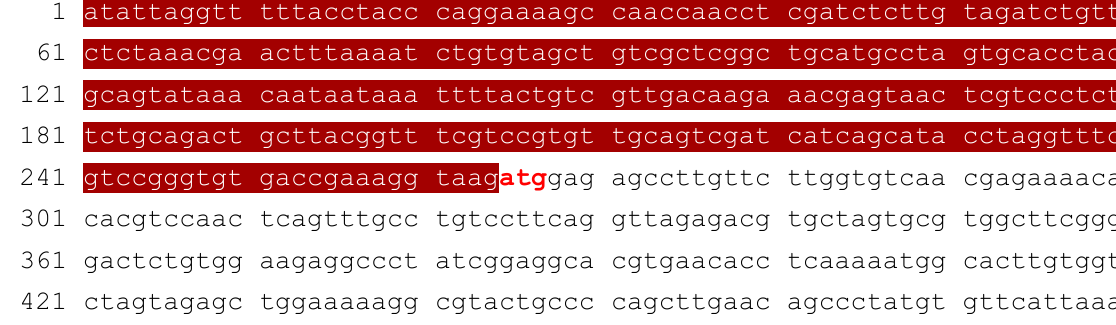
Figure 2. Sequence comparative alignment among SARS-CoV-2, bat-SL-CoVZXC21, and SARS-CoV-1 highlighting the 5 (cid:48) UTR (brown) and transcriptional start atg site of pp1a gene loci (red and